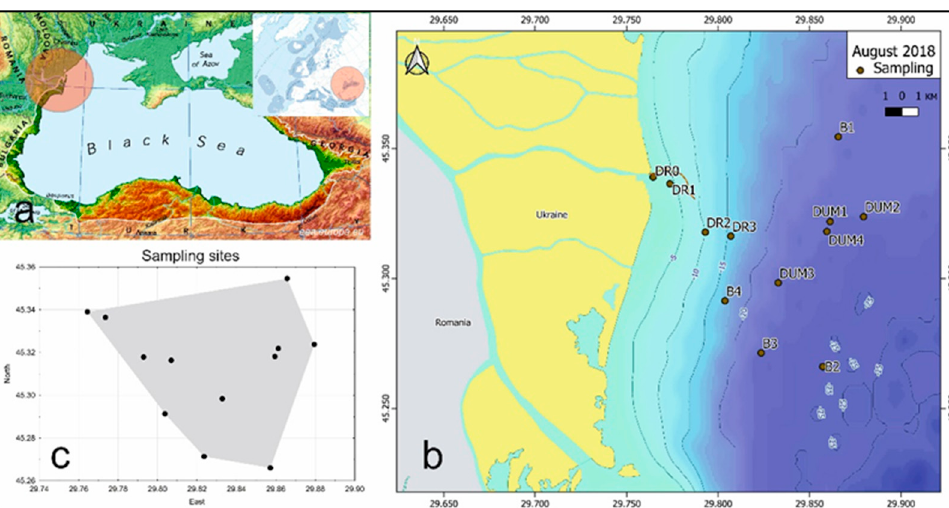
Figure 1. Sampling sites in the Ukrainian part of Danube nearshore area in August 2018 ( a , b ). Station names ( b ): DR—drainage area, DUM—dumping area, B—background area. Mapped area (gray) in the Statistica 12.0 program with sampling sites as black dots ( c ).